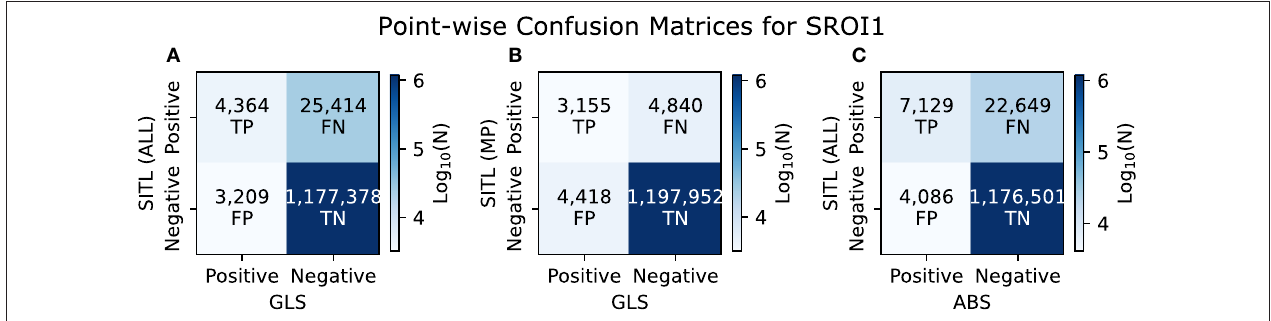
FIGURE 6 | Point-by-point comparison between (A) all SITL and GLS selections, (B) SITL selections filtered for magnetopause crossings and GLS selections, and (C) all SITL and ABS selections. Such a point-wise metric is typical for machine learning models but does not properly weight predictions with partial or multiple overlap, as when the SITL selects additional context around a given event ( Figure 4 , Orbit 1055), or when multiple GLS selections are encompassed by one SITL selection ( Figure 4 , Orbit 1058).